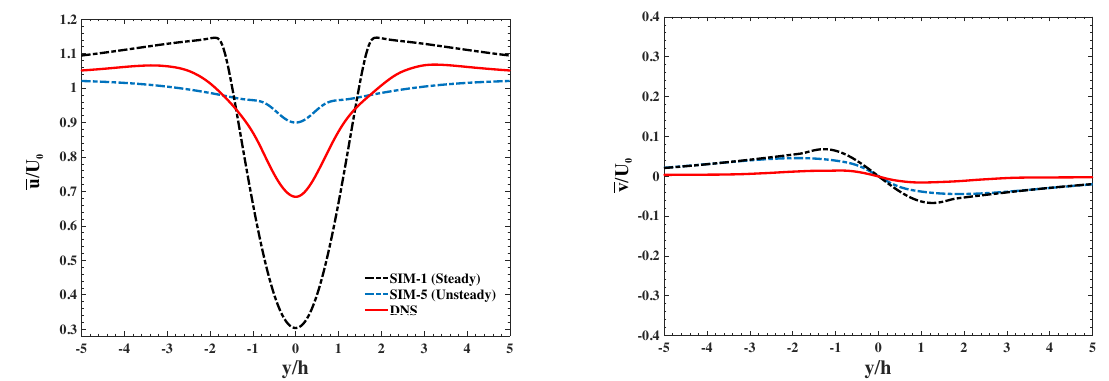
Figure 9. Comparison of mean velocities at x = 8 h , calculated by steady and unsteady k − ε and compared to Reference